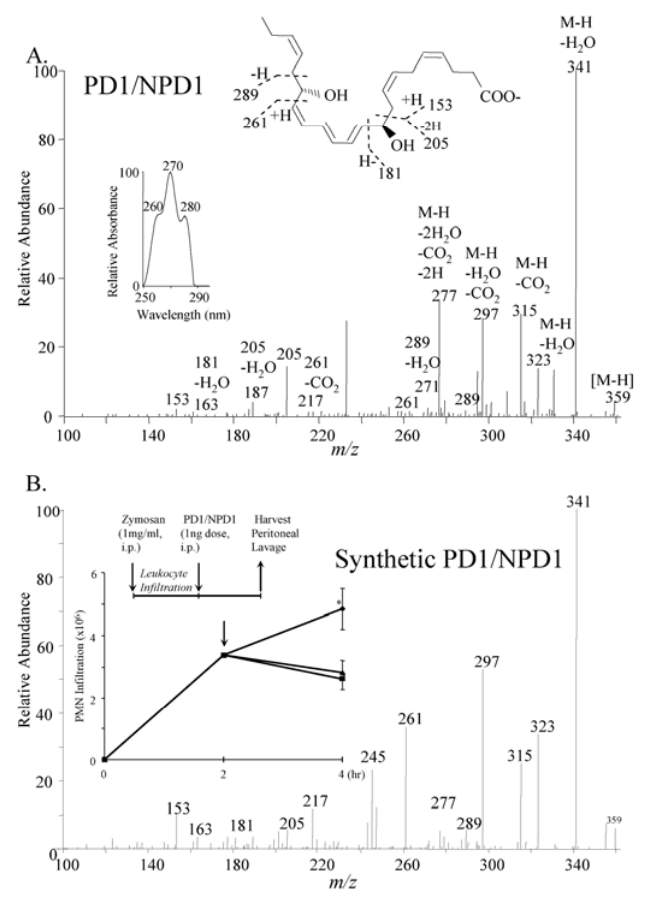
FIGURE 5. Mass spectra of biogenic and synthetic PD1/NPD1. (A) MS/MS spectrum of PD1/NPD1 generated in trout brain cells[38]. (B) MS/MS spectrum of synthetic PD1 with inset showing that PD1 treatment during the course of acute inflammation halts PMN infiltration (* p < 0.05) induced by zymosan[39].